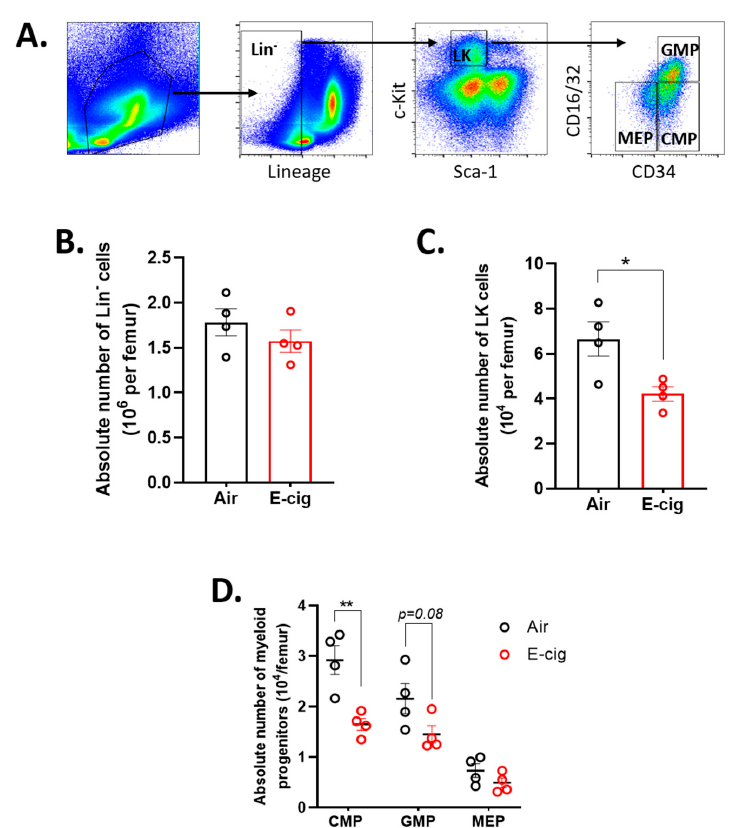
Figure 2. E-cigarette exposure suppresses myeloid progenitor cell numbers in the bone marrow. ( A ) Gating scheme for the characterization of progenitor cell sub-types. Absolute numbers of ( B ) lineage- (Lin-), ( C ) lineage-, c-Kit+ (LK) and ( D ) CMP, GMP and MEP per femur. Data are shown as mean ± SEM, n = 4 mice/group. * p < 0.05, ** p < 0.01, unpaired student’s t -test.